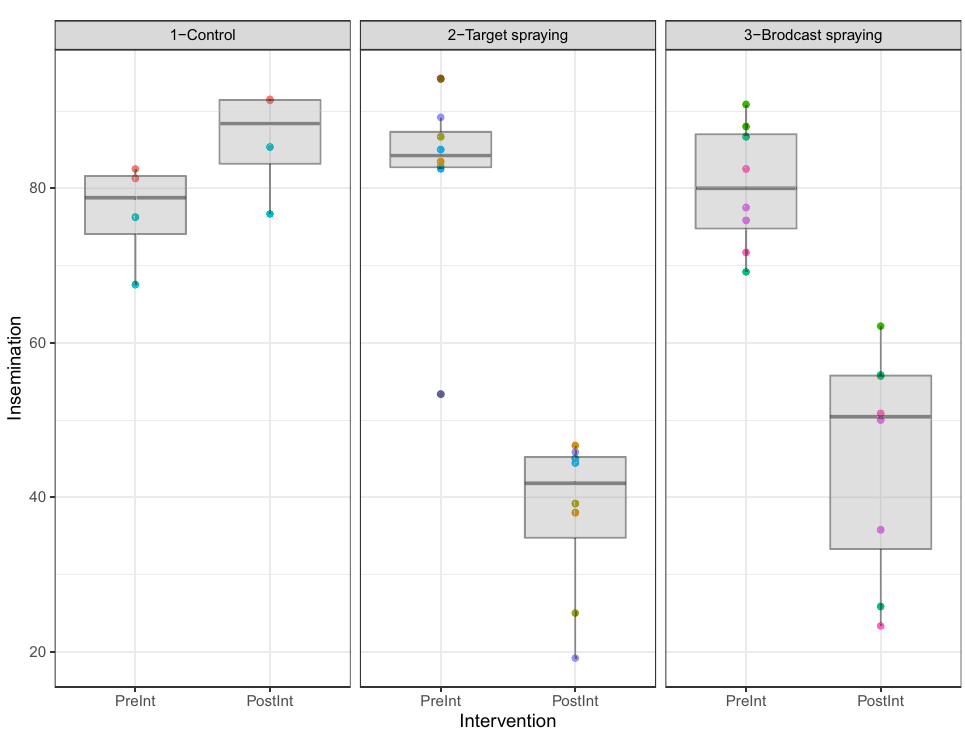
Figure 7. Plot of the insemination rate. Each village is represented as a colored point and a boxplot is added to visually represent the dispersion of the data around its mean, shown pre- and post-intervention. We found highly significant effects from targeted and broadcast spraying in decreasing insemination rate (p-value <